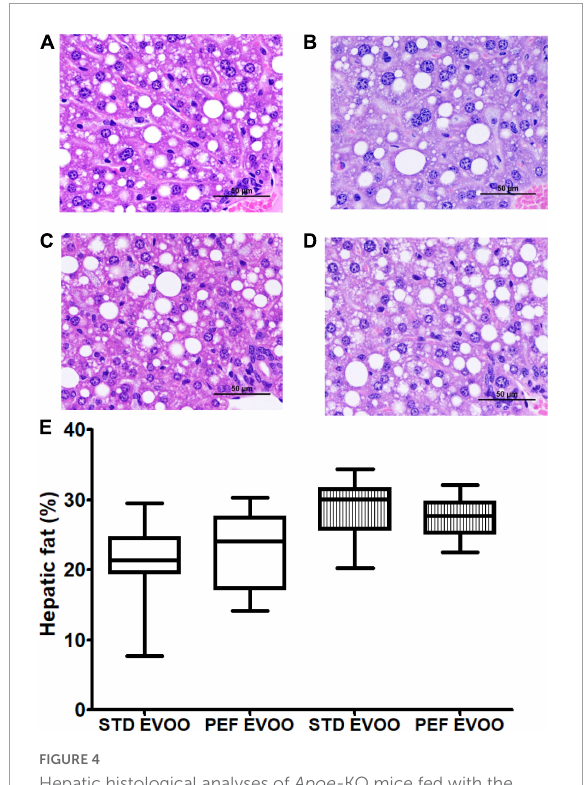
FIGURE4 Hepatic histological analyses of Apoe -KO mice fed with the different diets. Representative liver micrographs from male mice consuming standard EVOO (A) and PEF EVOO (B) . Female mice consuming standard EVOO (C) and PEF EVOO (D) . Liver sections from each animal were stained with hematoxylin and eosin and evaluated blindly. Morphometric evaluation of lipid droplet